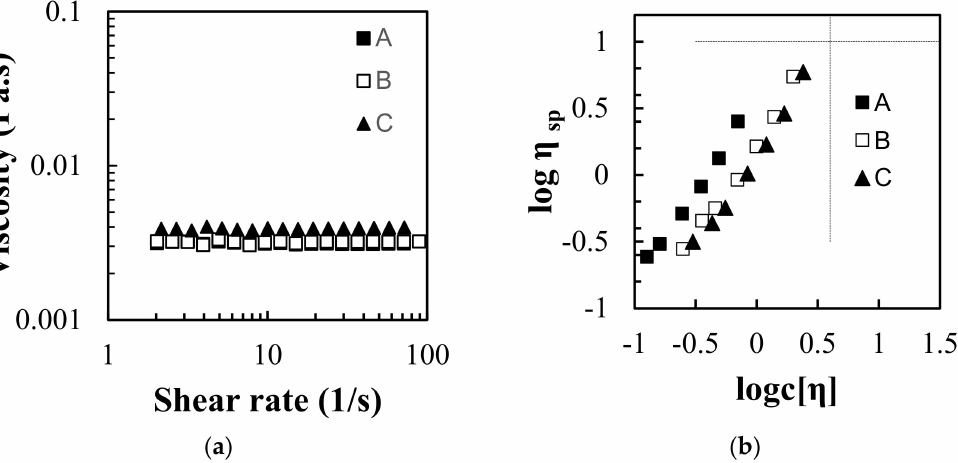
Figure 1. ( a ) Flow curves of 0.5 wt. % solutions and ( b ) η sp vs. c[ η ] plots of pectins A, B and C. Pectins A and B were extracted from orange peels using MAE (620 W, 1:25 w/v , 3 min) and UMAE (50/850 W, 1:20 w/v , 30/3 min), respectively. Pectin C was a commercial